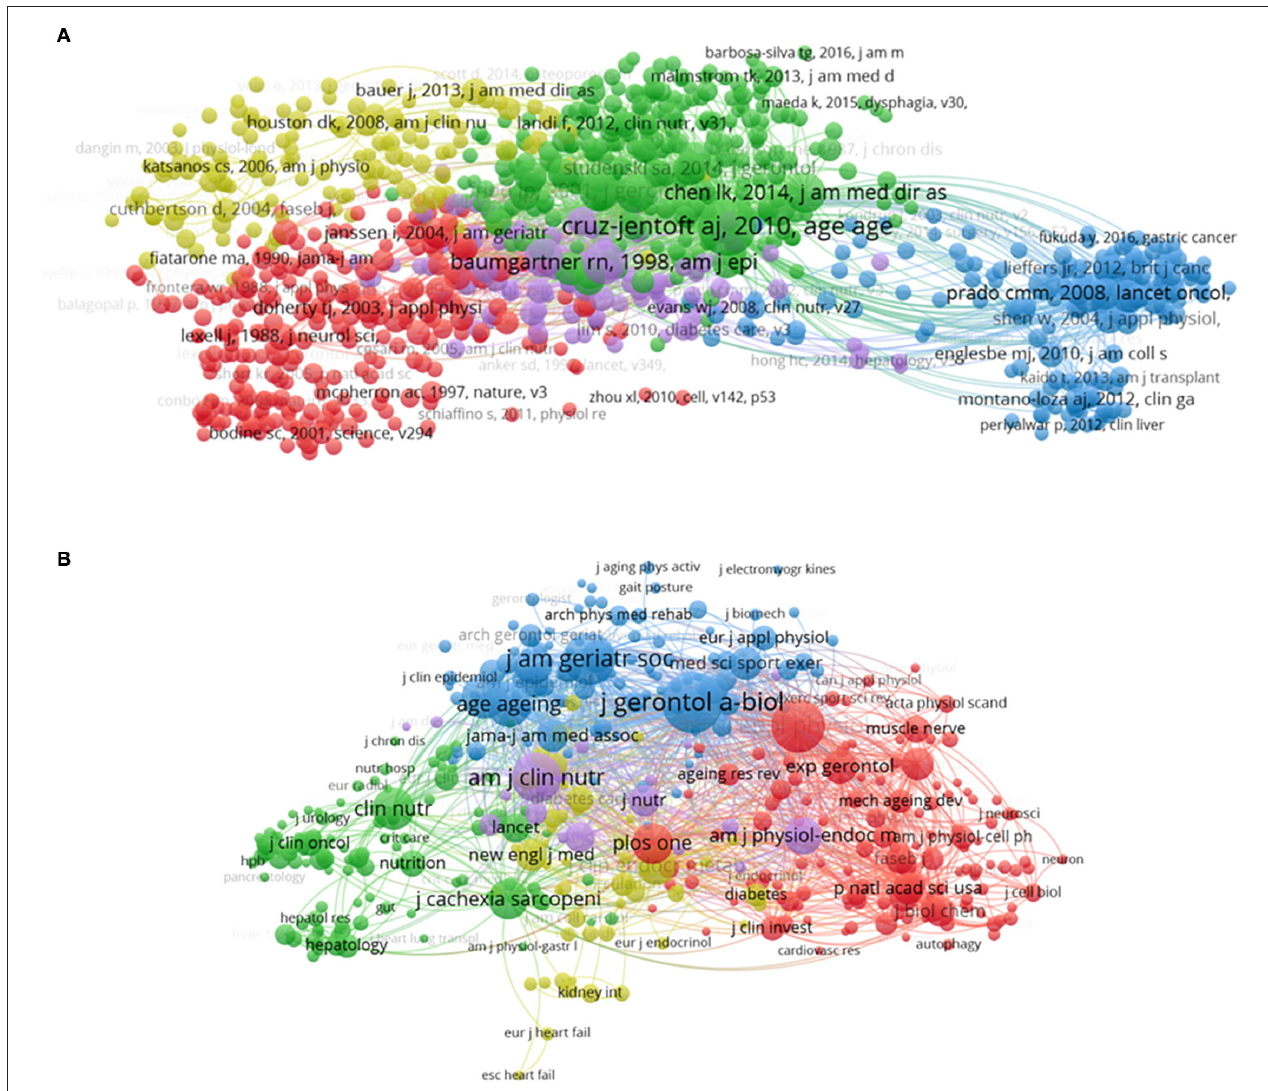
FIGURE 6 | Mapping of co-citation on sarcopenia. (A) Mapping of co-cited references (The 924 points with different colors represent the 924 cited references. The size of the points represents the citation frequency. A line between two points means that both were cited in one paper. A shorter line indicates a closer link between the two papers. Points in the same color belong to the same research direction). (B) Mapping of co-cited journals (The 409 points with different colors represent the 409 identified journals. The size of the points represents the citation frequency. A line between two points means that both were cited in one journal. A shorter line indicates a closer link between the two journals. Points in the same color belong to the same research